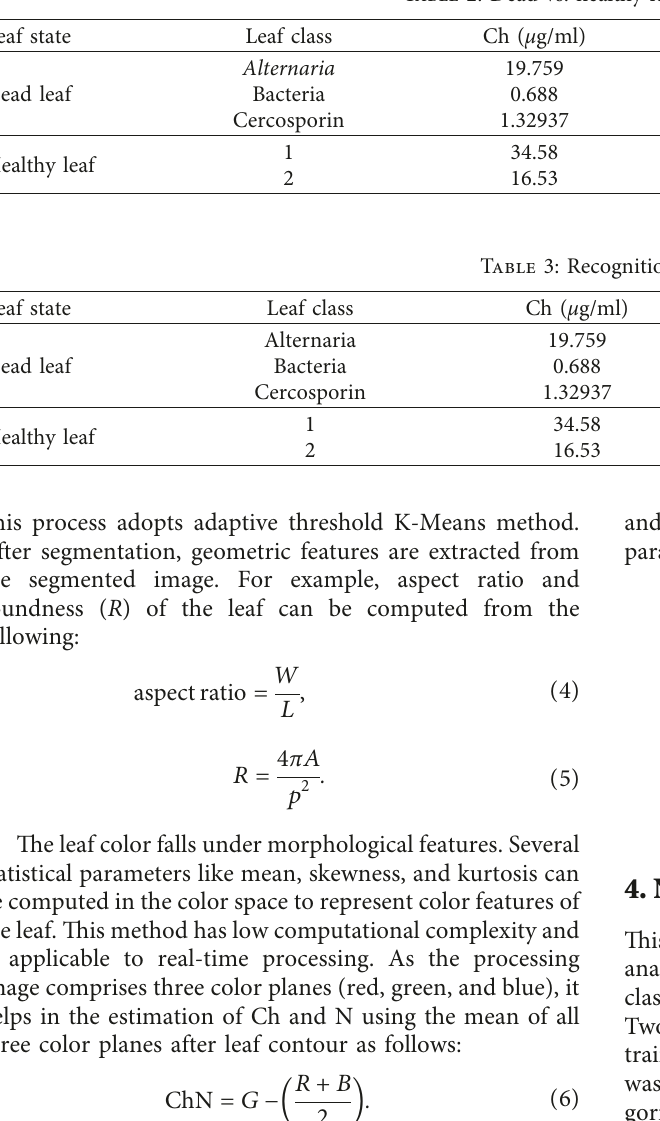
Table 2: Dead vs. healthy leaf gas analysis.